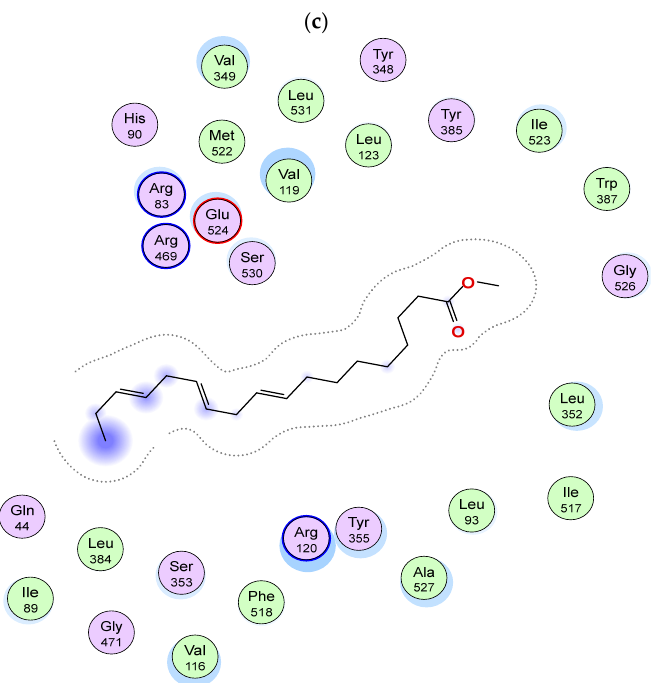
Figure 5. Two-dimensional diagram of the binding interactions of ( a ) metabolite 66, ( b ) metabolite 17 and ( c ) metabolite 46 with the active site residues of COX-1 enzyme. Magenta circles indicate polar amino acids and green circles indicate nonpolar amino acids.